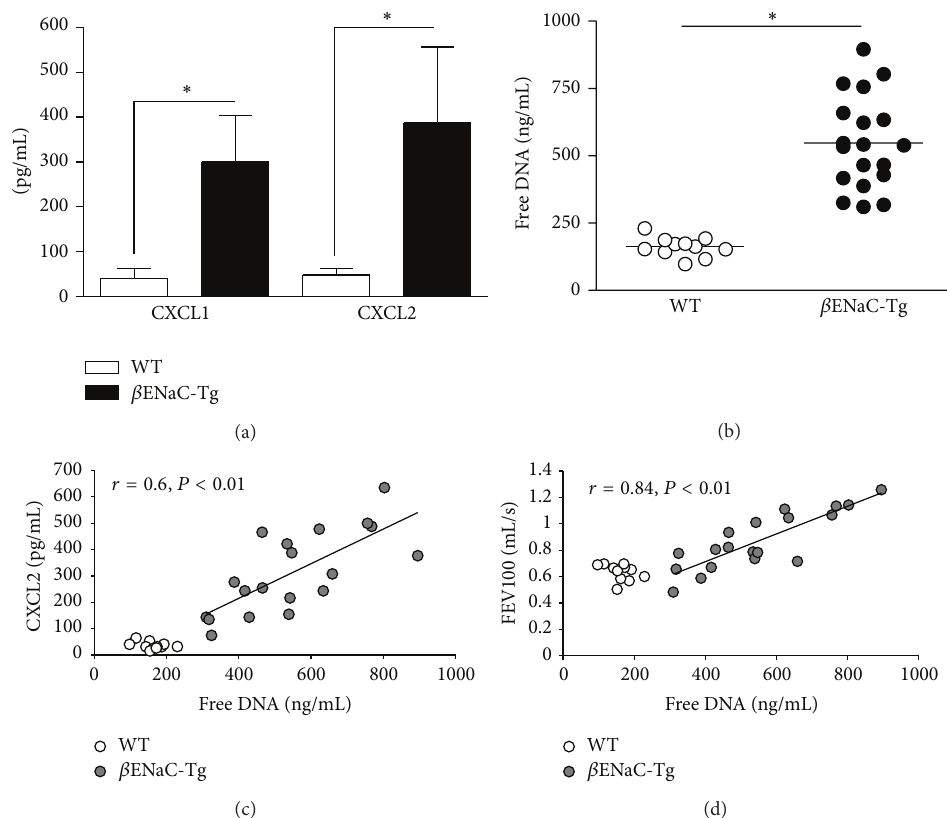
Figure 3: Free DNA in murine CF lung disease in vivo . (a) CXCR2 chemokines in BALF from 𝛽 ENaC-transgenic ( 𝛽 ENaC-Tg, 𝑛 = 19 ) and wild-type (WT, 𝑛 = 11 ) mice. Levels of CXCL1 (KC) and CXCL2 (MIP-2) were quantified by ELISA. (b) Free DNA in BALs from 𝛽 ENaC-Tg mice. Free DNA was quantified in BALF from 𝛽 ENaC-Tg (filled circles, 𝑛 = 19 ) and wild-type (empty circles, 𝑛 = 11 ) mice. (c) Correlation of free DNA with CXCL2 levels in BAL. (d) Correlation of free DNA with lung function (FEV100). ∗ 𝑃 < 0.05